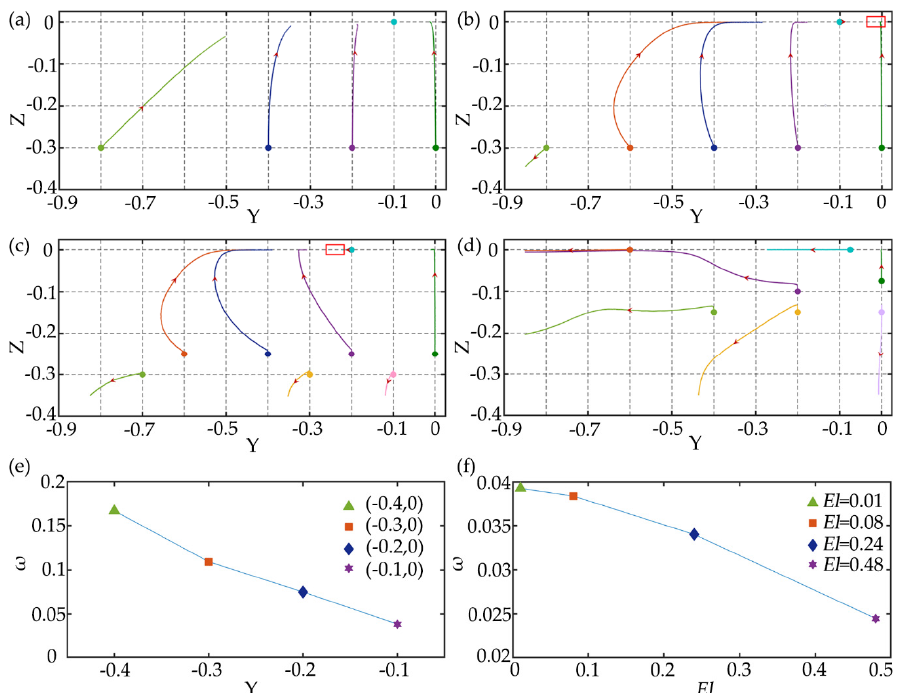
Figure 6. The migration trajectories of particles with the diameter of 6 μ m ( d / h = 0.15) at different initial positions of the cross-section in channel with AR =1/2 under Re = 2.5, ( a ) Wi = 0.005, El = 0.01; ( b ) Wi = 0.2, El = 0.08; ( c ) Wi = 0.6, El = 0.24; ( d ) Wi = 1.2, El = 0.48. The red boxes in the figures are the